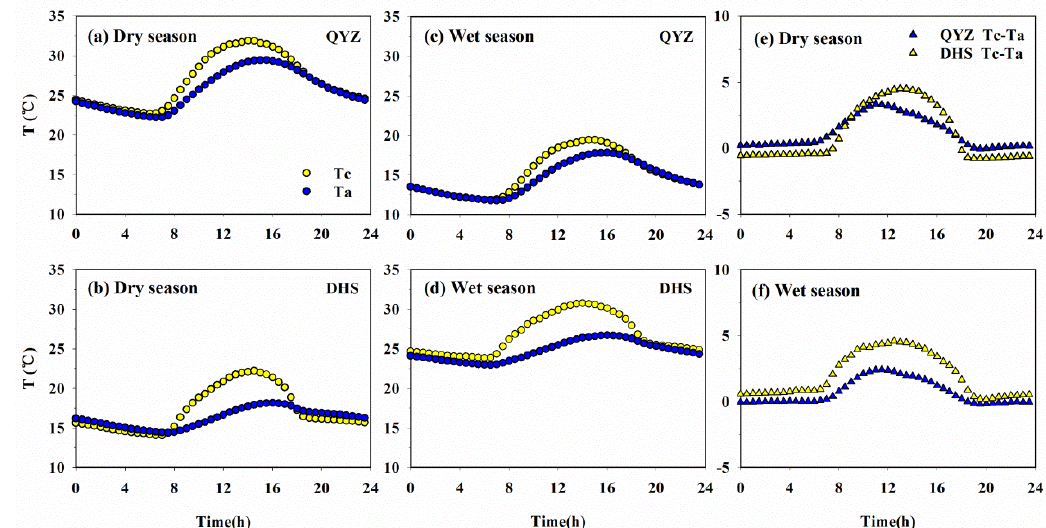
Figure 3 . Mean diurnal variations of Tc, Ta, and ΔT in the dry and wet seasons at the QYZ and DHS Figure 3. Mean diurnal variations of Tc, Ta, and ∆ T in the dry and wet seasons at the QYZ and DHS sites. Tc, canopy temperature; Ta, air temperature; ΔT, canopy-to-air temperature difference. Tc and sites. Tc, canopy temperature; Ta, air temperature; ∆ T, canopy-to-air temperature di ff erence. Tc and Ta in the dry ( a ) and wet season ( c ) at the QYZ site; Tc and Ta in the dry ( b ) and wet season ( d ) at the DHS site; ∆ T in the dry ( e ) and wet season ( f ) at both sites. DHS, Dinghushan; QYZ, Qianyanzhou.